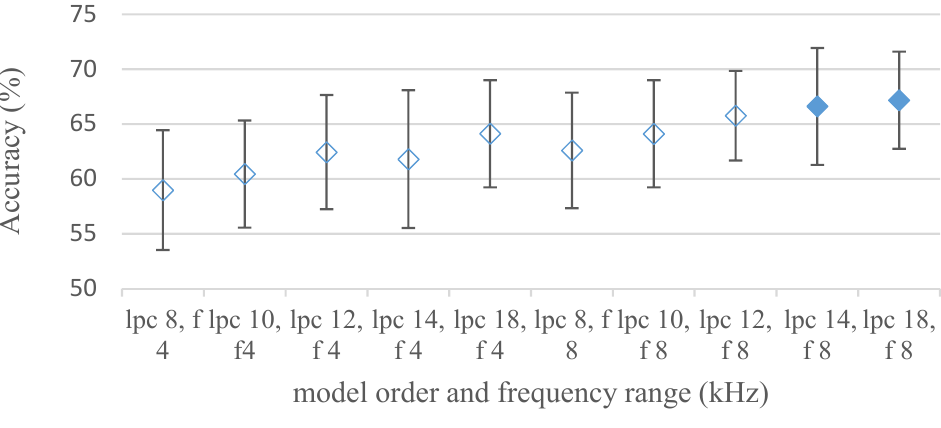
Figure 13. Averaged accuracies and standard deviations for linear prediction coefficient (LPC) model orders (lpc) ranging from 8 to 18, for 4 and 8 kHz maximal frequencies (f), and no pre-emphasis. Filled marks show equally performing